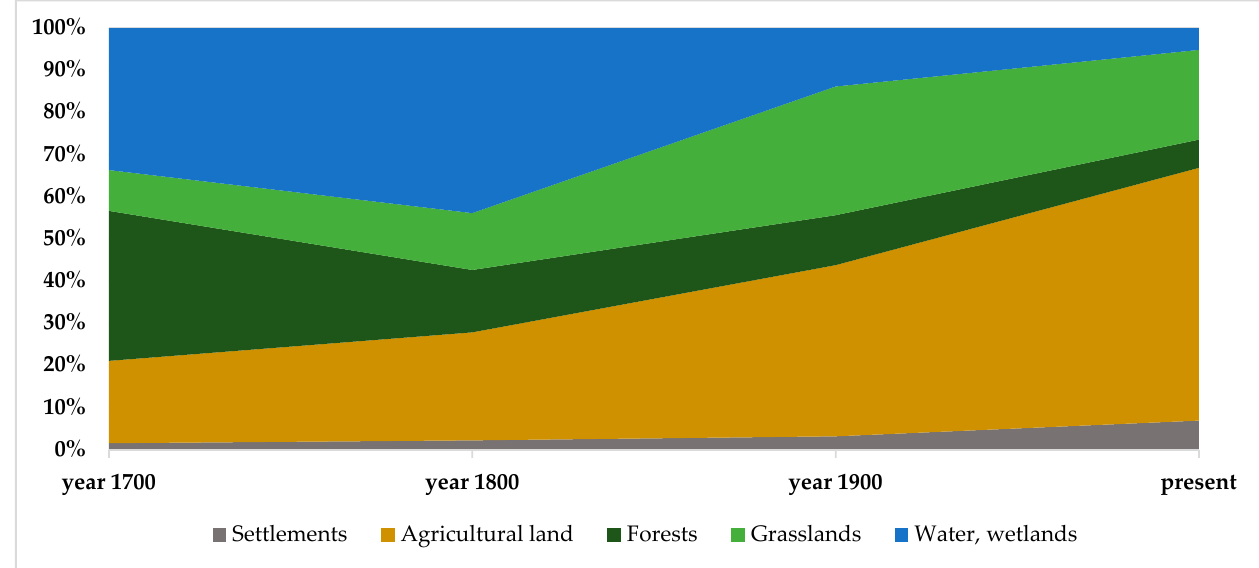
Figure 1. Changes in land use in the lowland territories of Slovakia from 1700 .